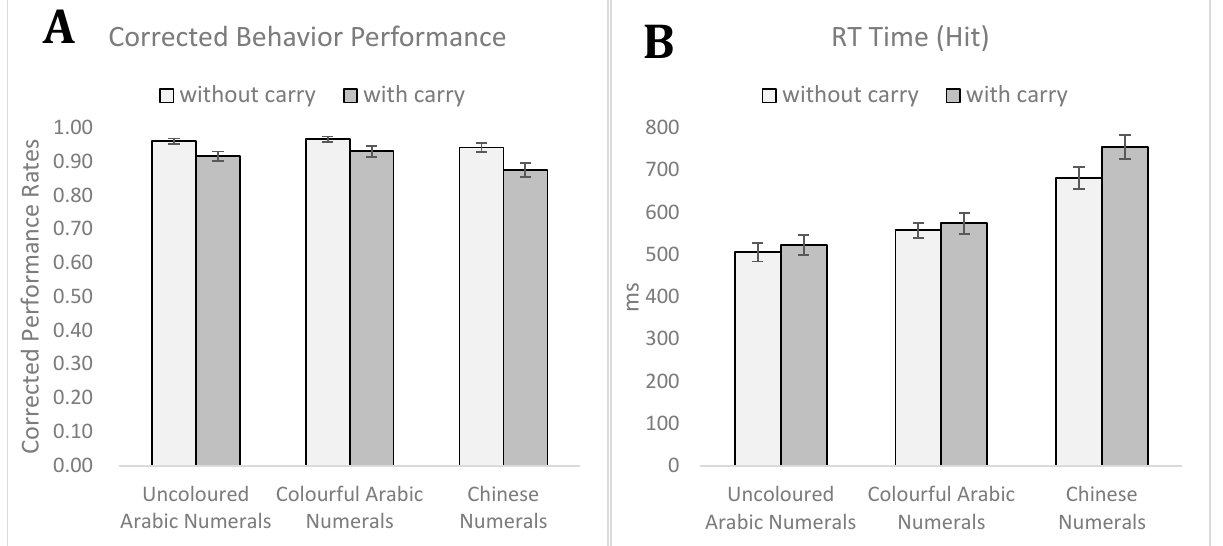
Figure 2. The mean corrected behavioural performance in percentages (hit–false alarm) ( A ) and mean reaction time in milliseconds (hit response) ( B ) of three conditions in the simple addition without carryover and with carryover arithmetic operation. Error bars indicate standard errors.